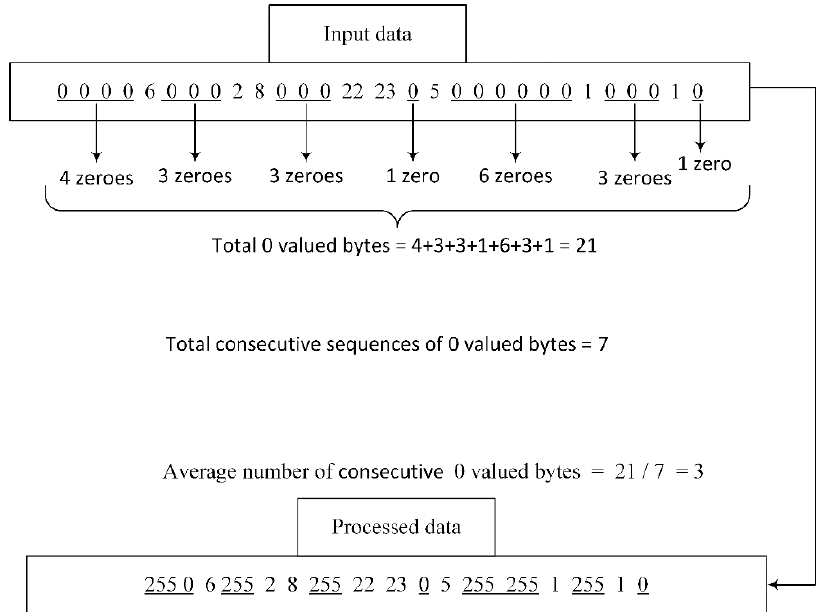
Figure 3. Replacement of values .